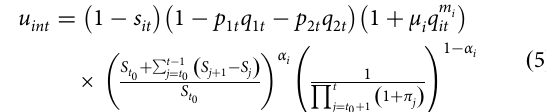
Fig. 2, i.e. q sensitivity and initial condition are k